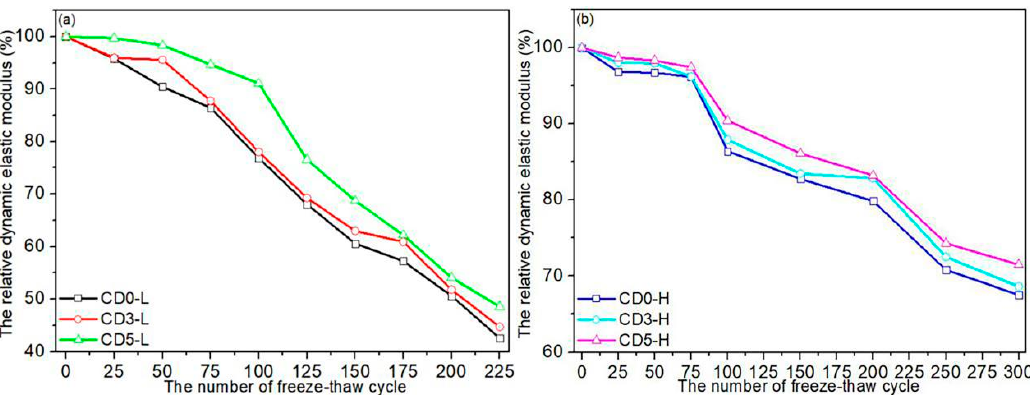
Figure 7. The relationship between the relative dynamic elastic modulus and the number of freeze– thaw cycles of concretes incorporating dolomite powder: ( a ) C30 concretes; ( b ) C45